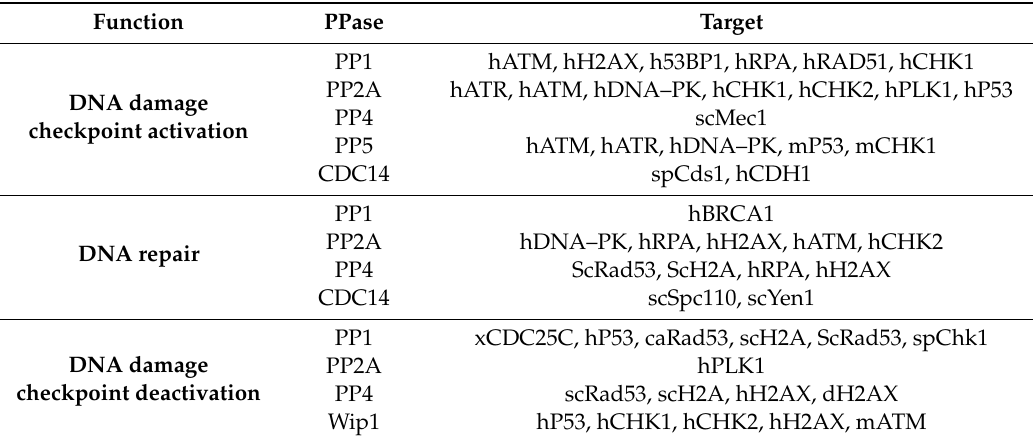
Table 1. A global overview of the role of protein phosphatases in the DNA damage response (DDR). The table contains information regarding the functions and targets of di ff erent protein phosphatases that are implicated in the regulation of the DNA damage